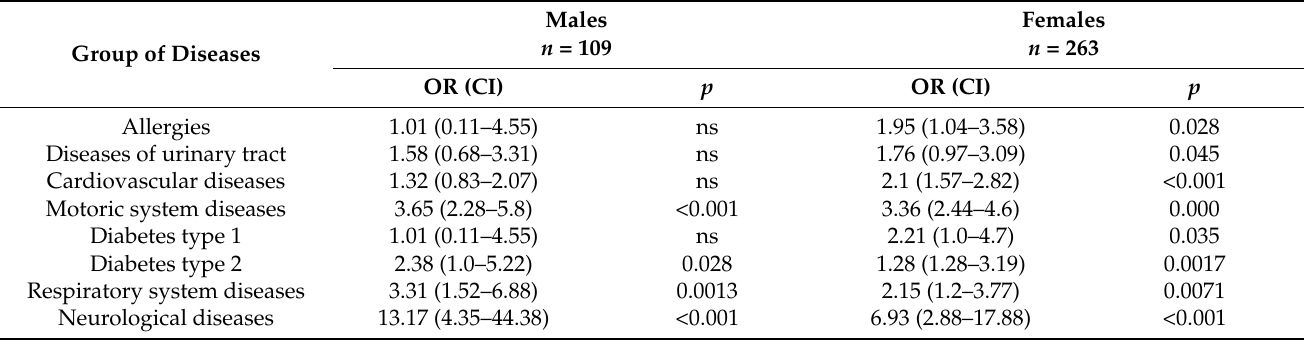
Table 5. Diseases present in sarcopenic